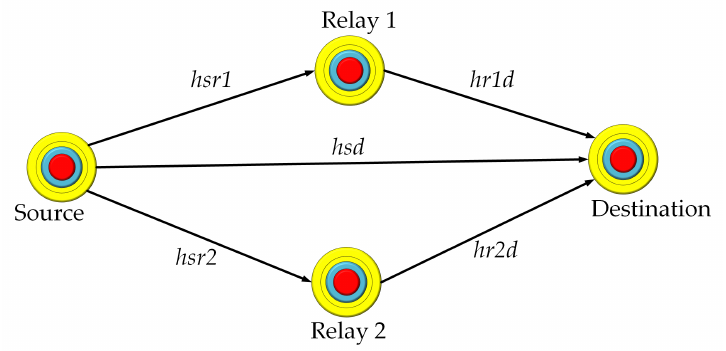
Figure 11. A simple model of